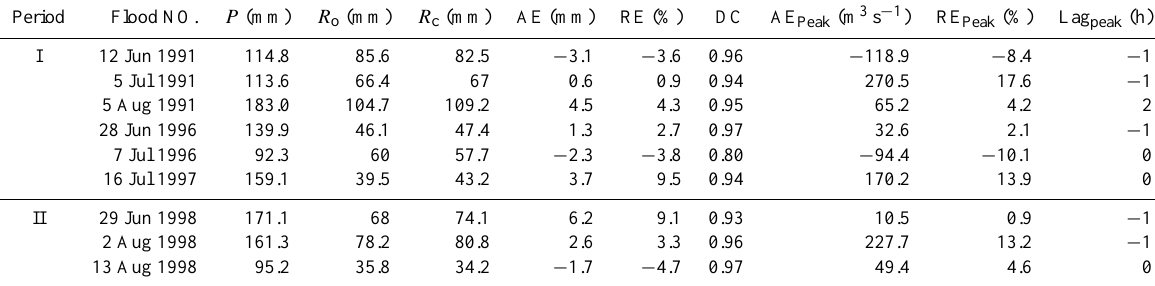
Table 6. Statistics of hourly calibrated and validated results for Dapoling sub-basin in 2000s. Period Flood NO. P (mm) R o (mm) R c (mm) AE (mm) RE (%) AE Peak (m 3 s − 1 ) Lag peak (h) I